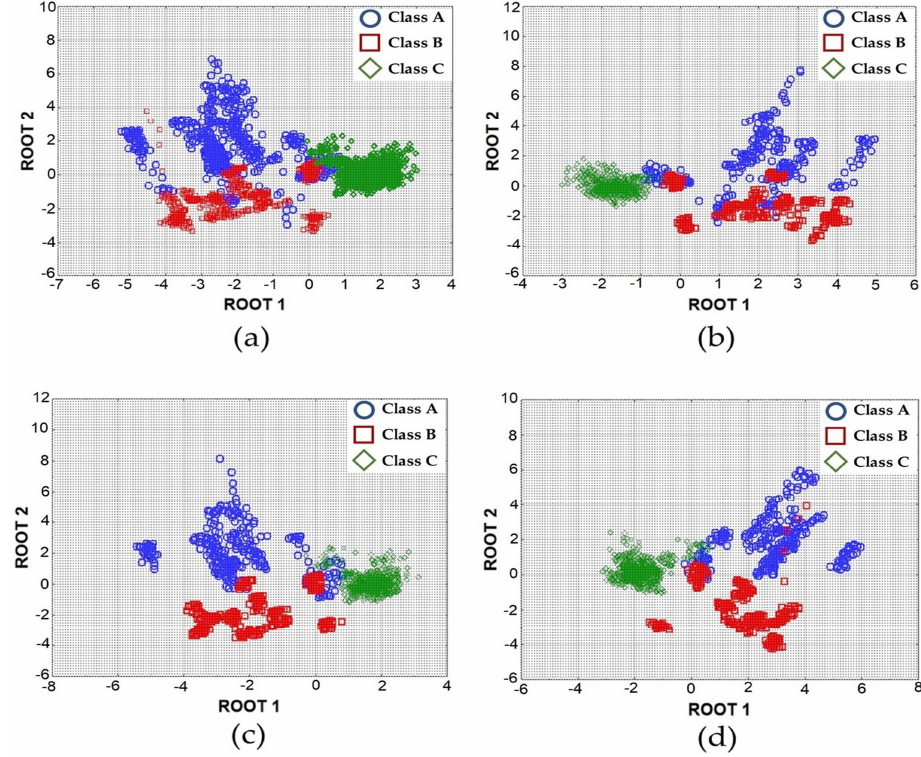
Figure 4. Scatterplots for the first two roots at different data extraction (( a ) complete response curve; ( b ) rise period; ( c ) intermediate period; ( d ) peak period).